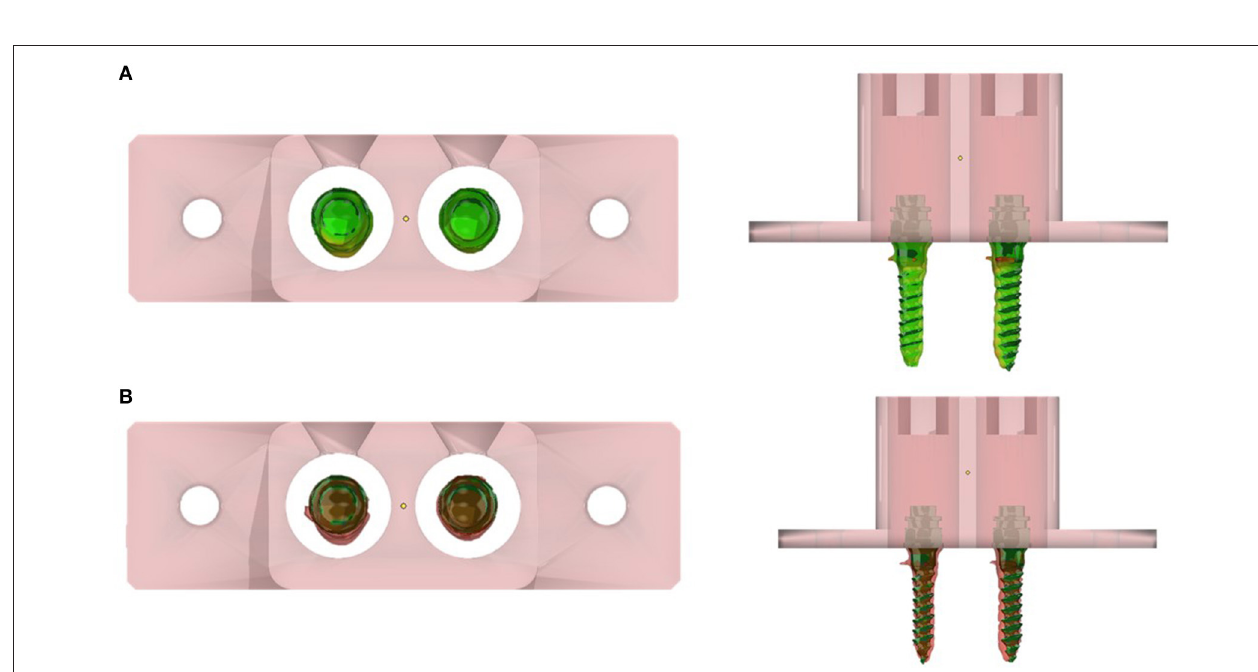
FIGURE 6 | 3D colour-coded matching/superimposition of inserted mini-implants and digitally planned position: (A) at 0.1-mm deviation, and (B) 0.5-mm deviation.